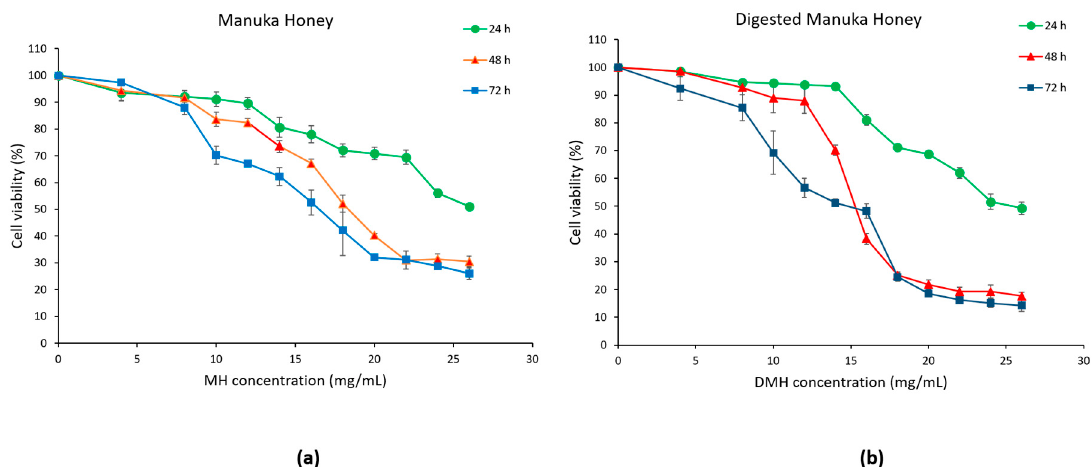
Figure 3. Inhibition of cell proliferation by MH ( a ) and DMH ( b ) in HCT-116 cells. The cells were treated with different concentrations of MH or DMH for 24, 48 and 72 h. Cell viability was measured using MTT and the results were expressed as % of viable cells. All data are expressed as the mean of three independent experiments ± SD.